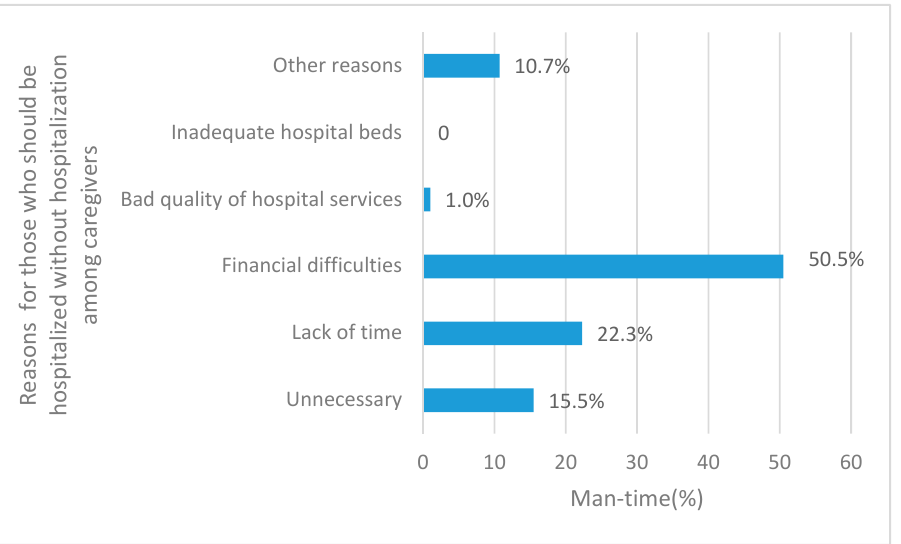
Figure 2. Reasons for those who should be hospitalized without hospitalization among caregivers in 2014.